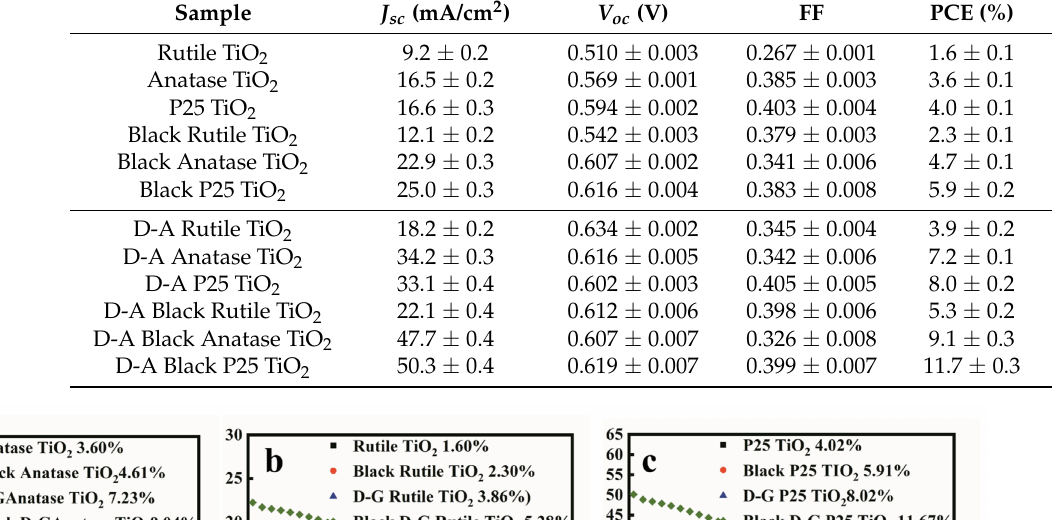
Table 1. Performance parameters of QDSSCS based on different photoanodes, and D-A means dual photoanodes.